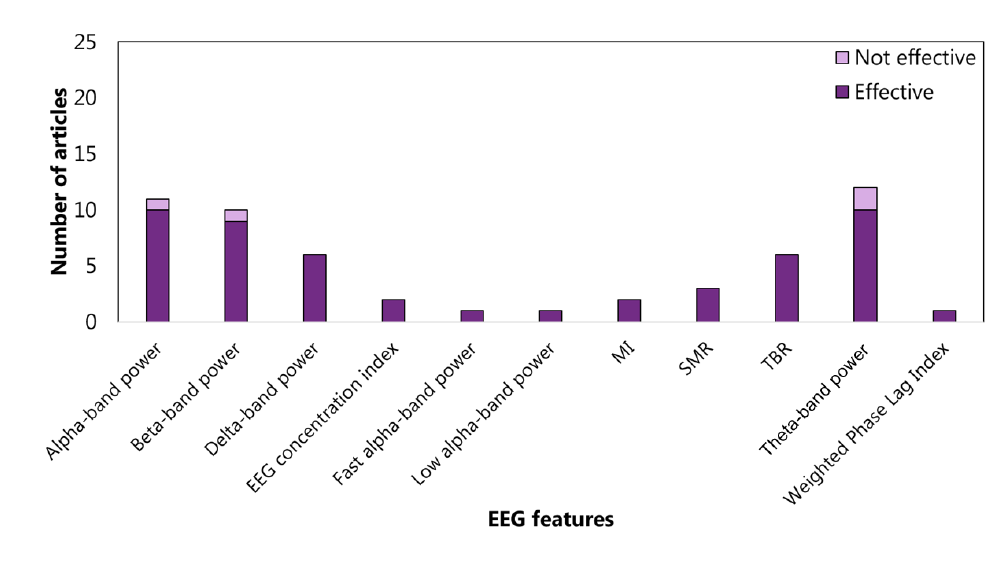
Figure 9. Articles focusing on the relationship between interference inhibition and EEG features from frequency domain. Theta-band power is the feature most studied: 10 articles verified (effective) the relationship, and 2 articles did not (not effective). TBR: theta-beta ratio; MI: modulation index; SMR: senso-motor rhythm; and CI: EEG consistency index.